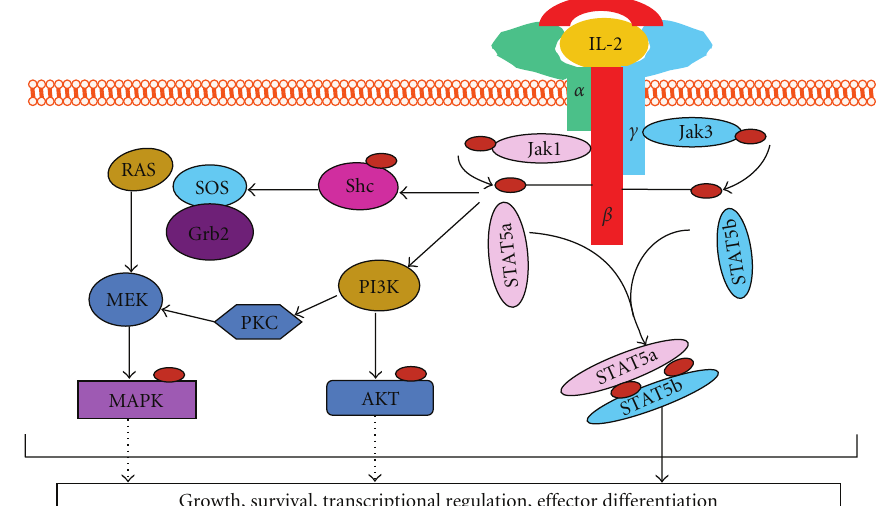
Figure 1: IL-2 receptor signaling. The binding of IL-2 to IL-2R leads to the initiation of signal transduction. Janus-activated kinase 3 (JAK3) molecules that are associated with the γ c, and JAK1 molecules that are associated with IL-2R β , phosphorylate ( ) tyrosine residues in the cytoplasmic tail of IL-2R β , the γ c and the JAK molecules themselves. The JAKs activation induced a cascade of activation of signal transducer and activator of transcription (STAT5a/b) factors, leading to their dimerization translocation to the nucleus, as well as phosphatidylinositol 3-kinse (PI3K) and ras-mitogen-activated protein kinase (MAPK) signaling pathways. These signaling molecules activation results in, modulation of target genes expression involved in cell cycles progression, antiapoptosis, and in the suppression of cytokine